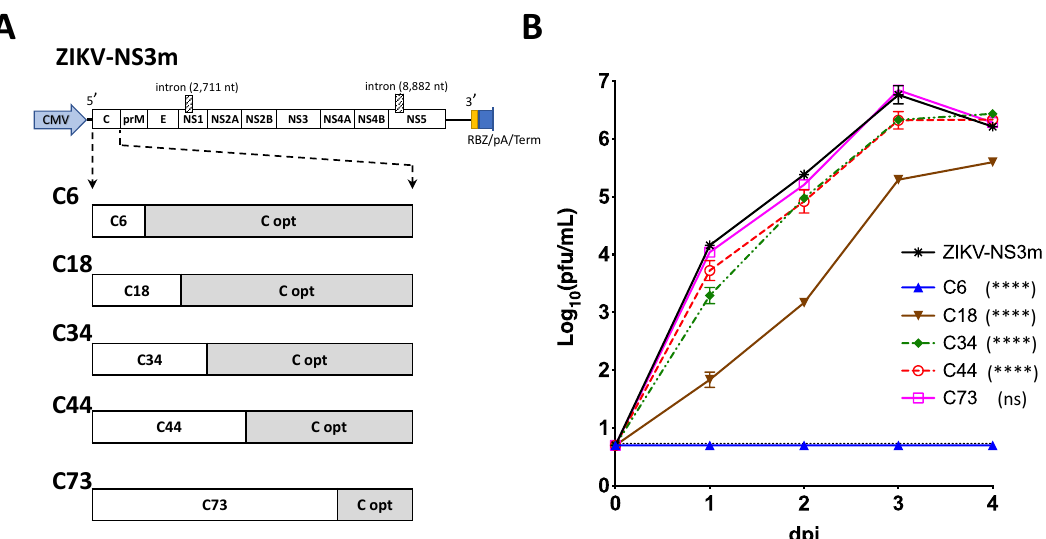
Figure 1. Mapping the region containing regulatory elements of the C gene of ZIKV. ( A ) Schematic representation of ZIKV-NS3m infectious clone (on top of ( A )), which was used to construct a panel of viruses with chimeric C gene sequence (on the bottom of ( A )). White boxes represent wt sequence of ZIKV-NS3m. Gray boxes (C opt) represent sequences that were mutated by synonymous substitutions. ( B ) Growth kinetics of viruses with chimeric C gene sequence in Vero cells after plasmid DNA transfection. Mean viral titer ± standard deviations in the samples that were collected daily from duplicate flasks were determined by titration in Vero cells. Dotted line (the one right above the blue C6 line) represents limit of virus detection (0.7 log 10 pfu / mL). Di ff erences between growth of ZIKV-NS3m and that of the other constructs were compared using two-way ANOVA (**** p < 0.0001; ns—not significant, p >